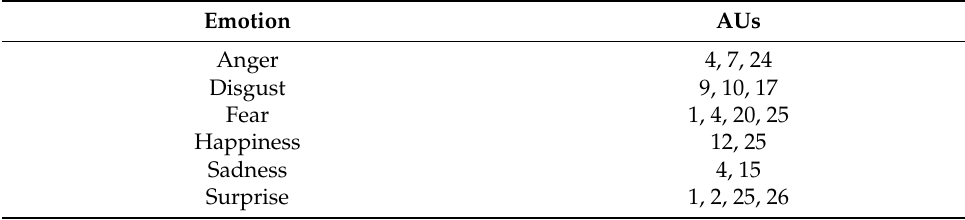
Table A4. Specific AUs involved in the basic emotions according to